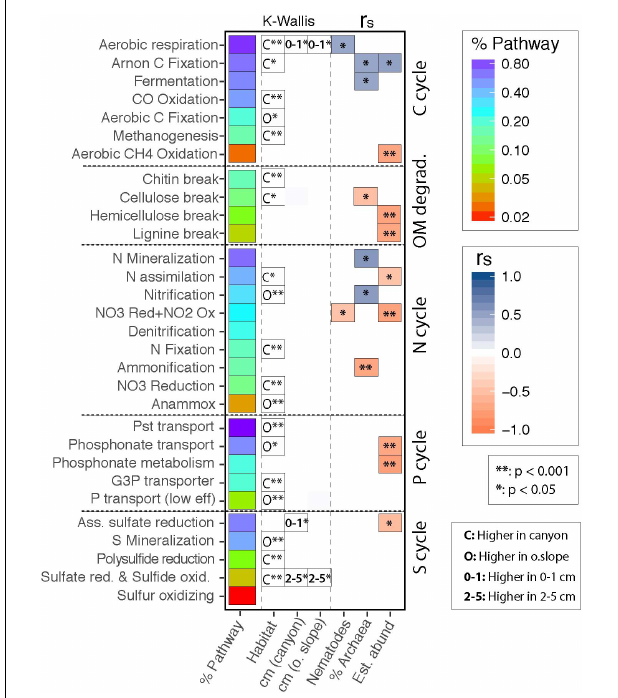
FIGURE 9 | Predicted functional pathways sorted by mean dataset abundance and element. Significant differences for each pathway are shown for spatial factors (Habitat and Sediment Layer in the Canyon and on the Slope separately), nematodes and microbial abundances, and the % of archaea/sample. The heatmap displays statistically significant relationships after fdr adjustment ( ∗∗ p < 0.001, ∗ p < 0.05), according to Kruskal–Wallis test (spatial factors) and spearman correlations (univariate metrics). C/O 0-1/2-5 indicate the factor level harboring a significantly increased value, and the color scale the Spearman’s r